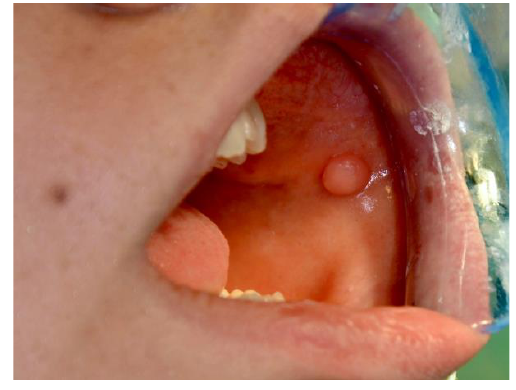
Figure 5. Fibroma.